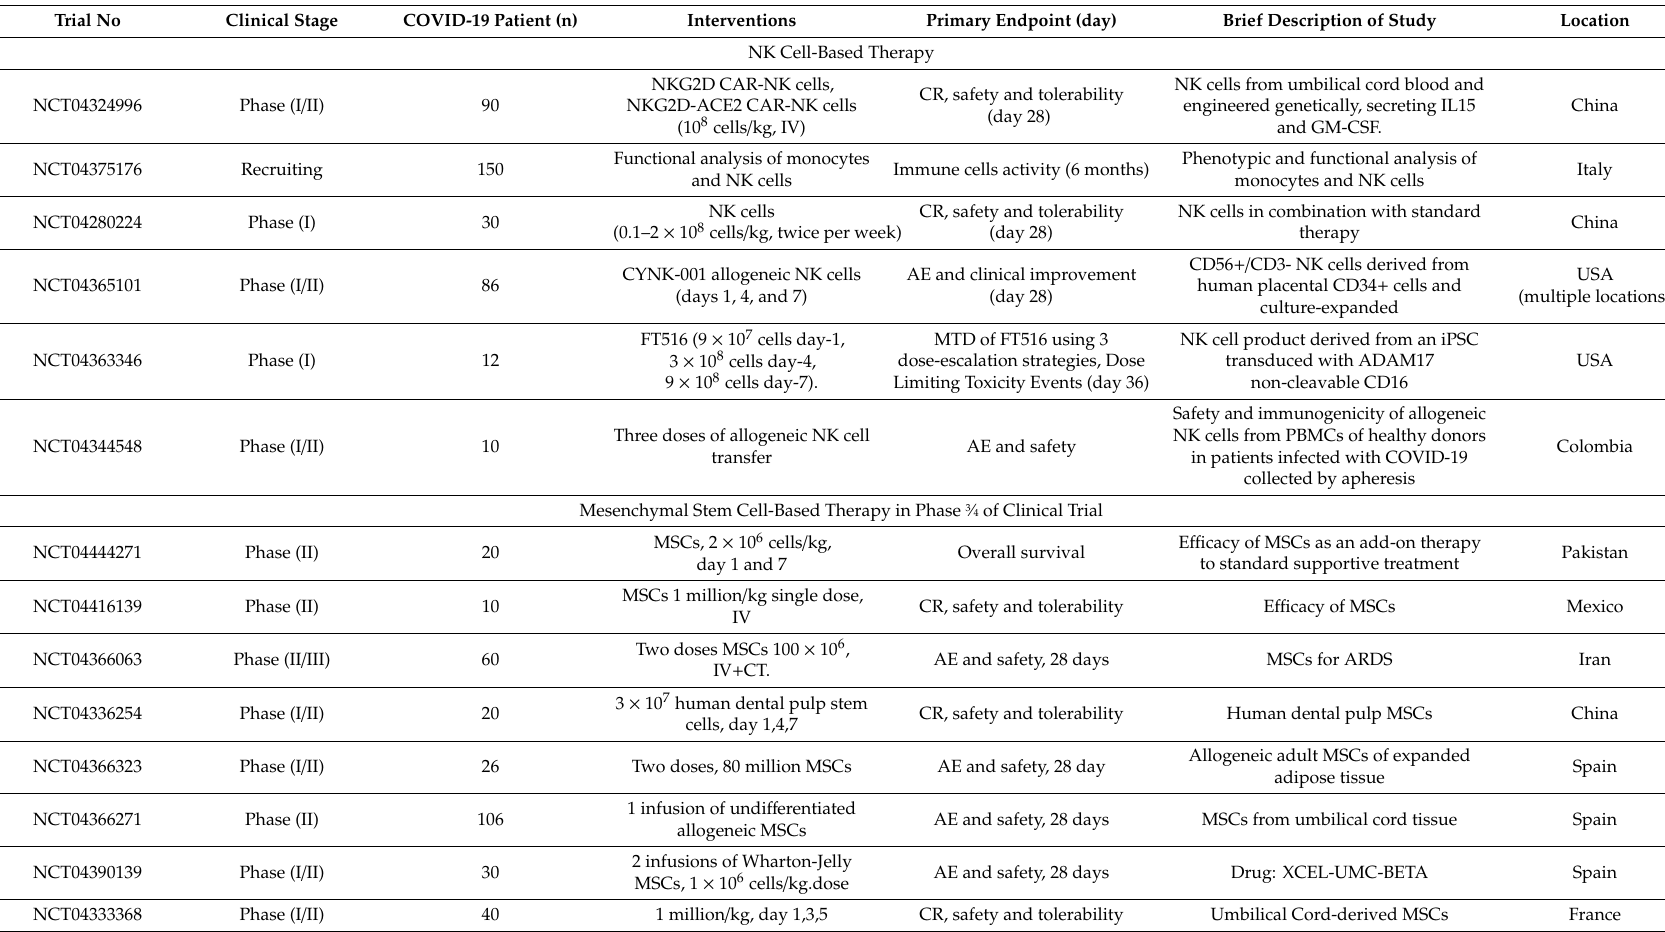
Table 1. Selected clinical studies using stem cells, adoptive cells, and extracellular vesicle-based treatment approaches for SARS-CoV-2